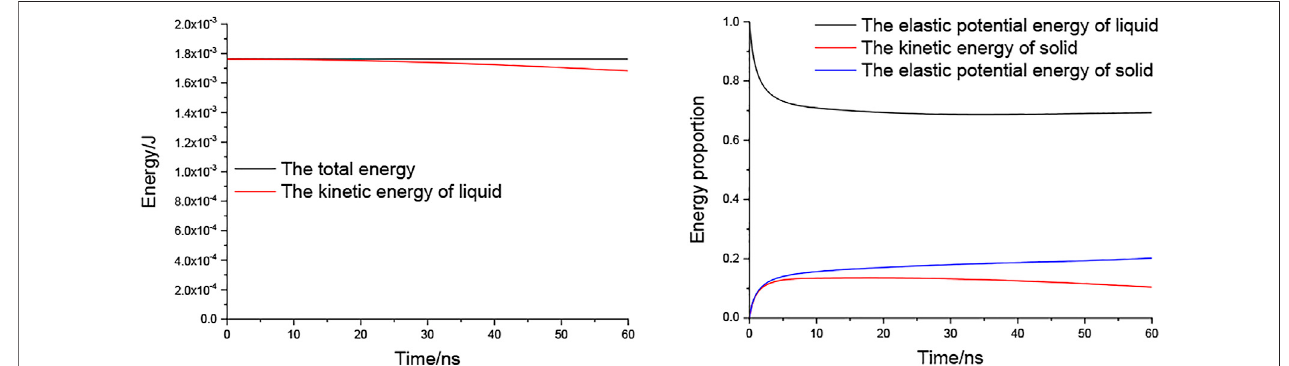
FIGURE 5 | The energy conversion process of the impact